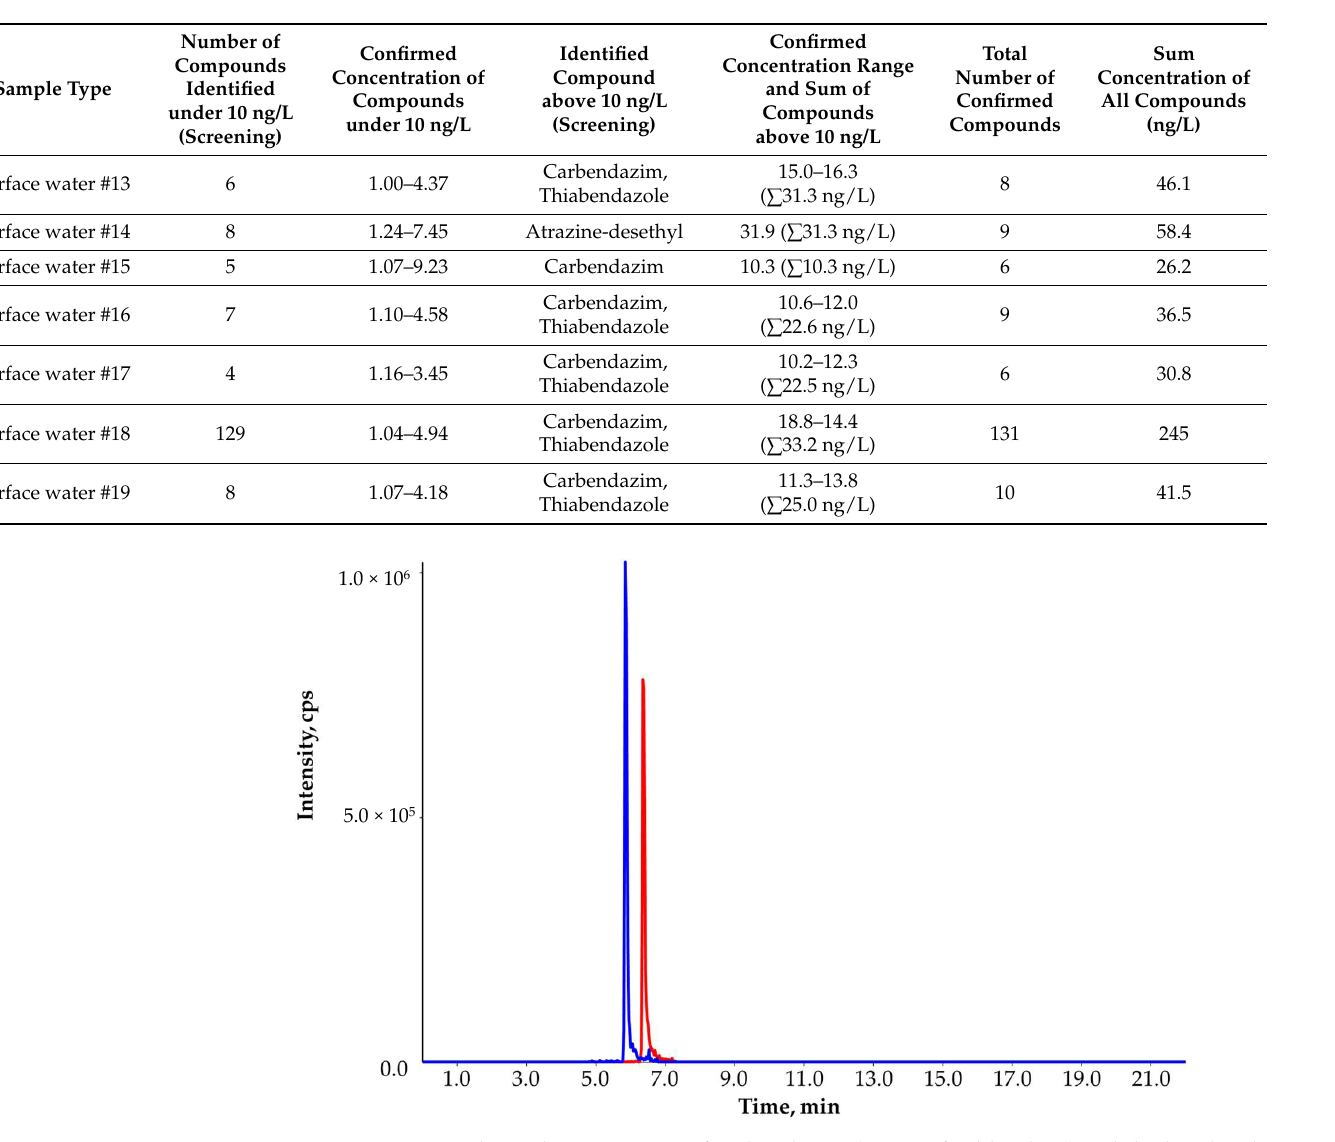
Figure 6. Extracted ion chromatogram of carbendazim (10.3 ng/L; blue line) and thiabendazole (10.4 ng/L; red line) in the surface water #8.